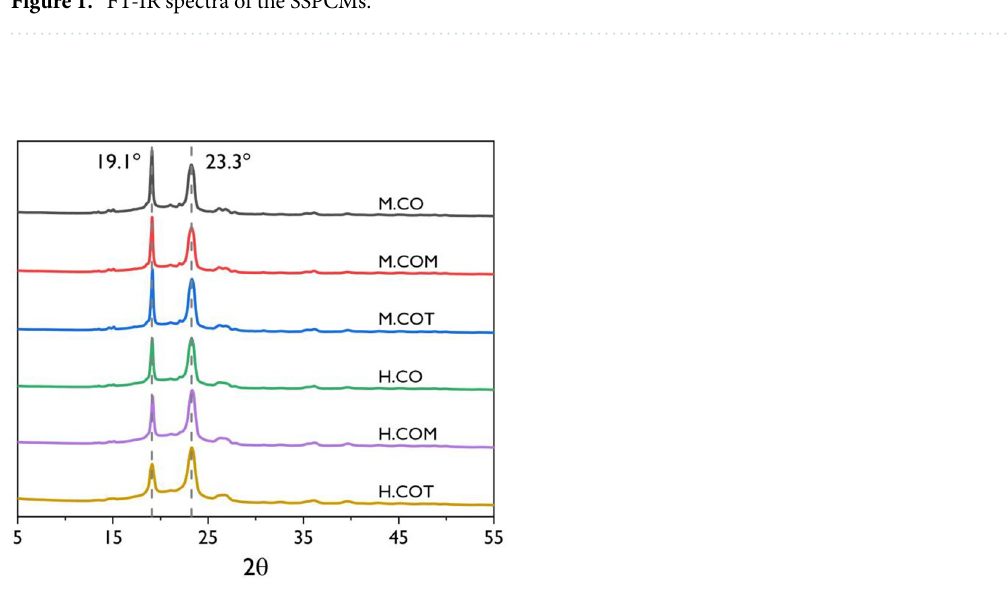
Figure 2. XRD patterns of the